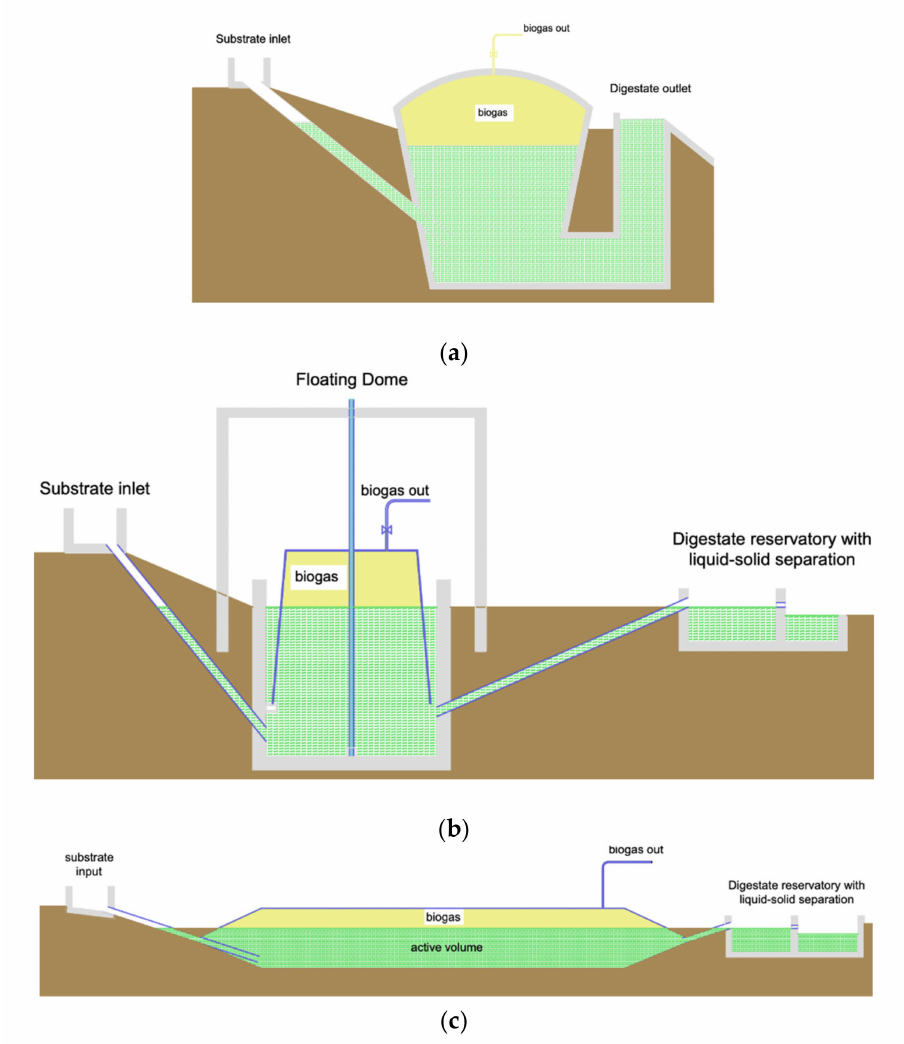
Figure 3. Schematics of prevalent types of digesters: ( a ) Fixed dome, a gas-tight chamber constructed of bricks, stone or poured concrete (modified from An et al. [52]); ( b ) Sasse floating drum model (modified from Zang et al. [51]) ( c ) tubular (flexible balloon) digester (modified from Zang et al.